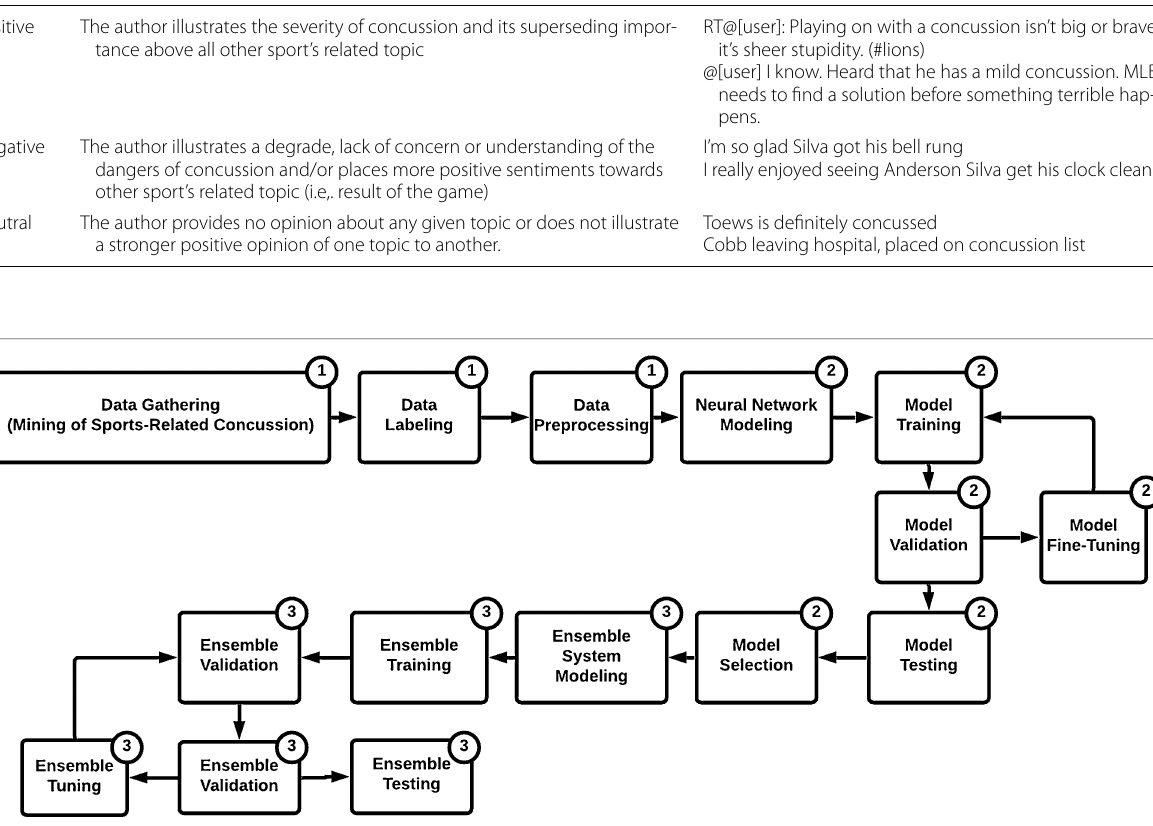
Fig. 1 Block diagram illustrating the 3 main phases of work: (1) Data framework, (2) Deep Neural Network framework, and (3) Ensemble